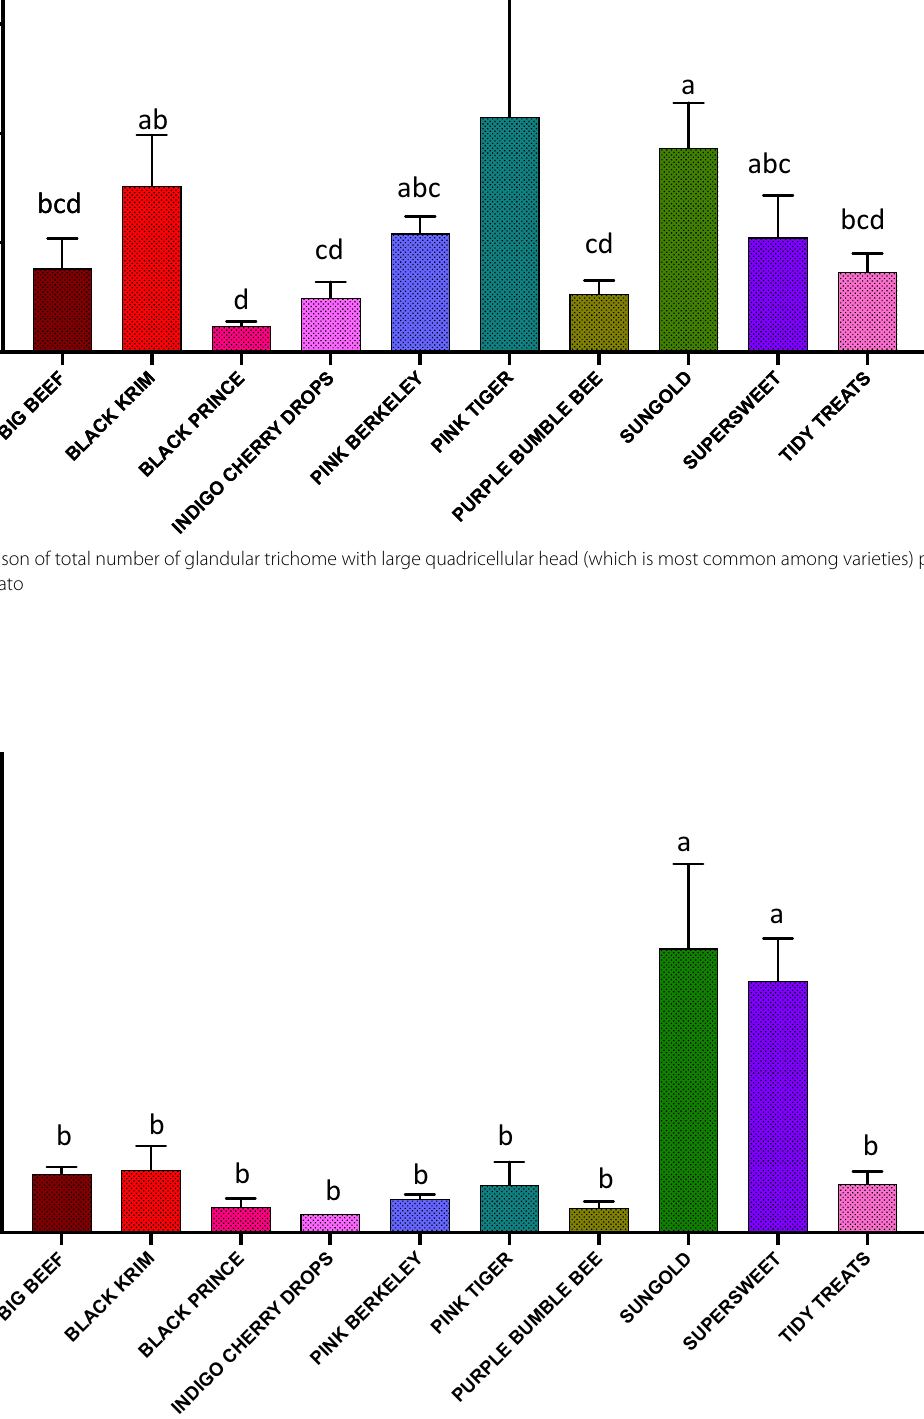
Fig. 7 The comparison of total number of the most common non-glandular trichome (crescent non-glandular with multi-cellular jointed stalk) trichomes present in ten varieties of